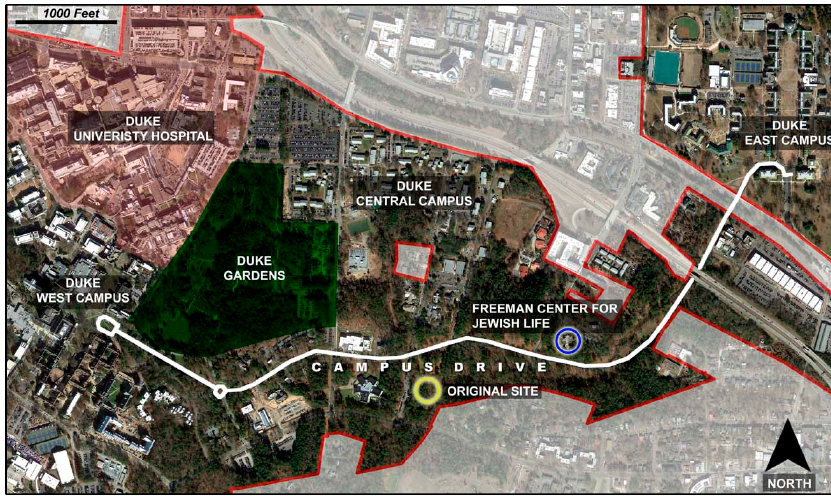
Figure 9. Freeman Center for Jewish Life at Duke, Location Plan. Image Credit: map data © 2018 Google, Landsat/Copernicus; reuse according to Google’s Terms of Service. Annotations by the author.